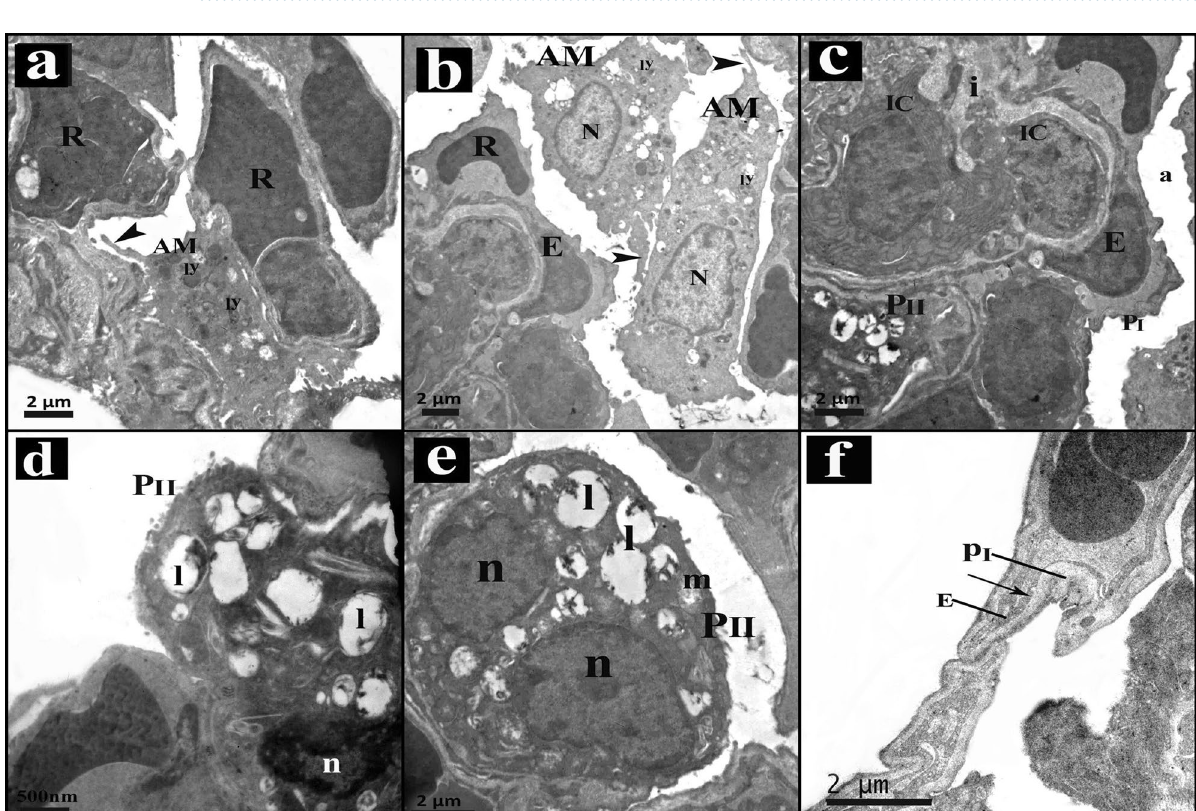
Figure 5. An electron micrograph of sections in lung of intestinal I–R group. ( a) Congested capillaries with RBCs (R) are in the interalveolar septum. Within the alveolar lumen, alveolar macrophage (AM) with pseudopodia (arrow head) and lysosomes (ly) is seen. ( b) Alveolar macrophage (AM) can be seen in the alveolar lumen, they have pseudopodia (arrow heads), heterochromatic nucleus (N) and lysosomes (ly). A capillary appears with its endothelial cell (E) and red blood cell (R) in the lumen. ( c) Alveolar lumen (a) lining shows pneumocytes type I (PI), the capillary appears with its endothelial cell (E). The interstitium (i) is infiltrated with inflammatory cells (IC). Notice pneumocytes type II (PII). ( d) Type II pneumocyte (PII) shows heterochromatic irregular nucleus (n) and distorted vacuolated lamellar bodies (l). ( e) Pneumocyte type II (PII) has divided nucleus (n), some degenerated mitochondria (m) and vacuolated lamellar bodies (l). ( f) Deformed blood air barrier composed of swollen irregular cytoplasm of type I pneumocytes (PI), fused basal lamina (arrow), and capillary endothelial cells’ cytoplasm